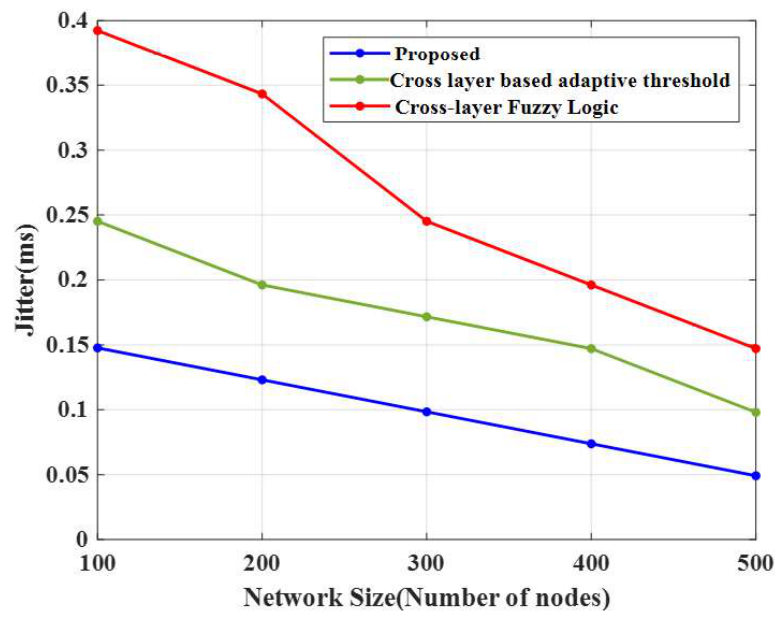
Figure 11. Comparison of jitter.